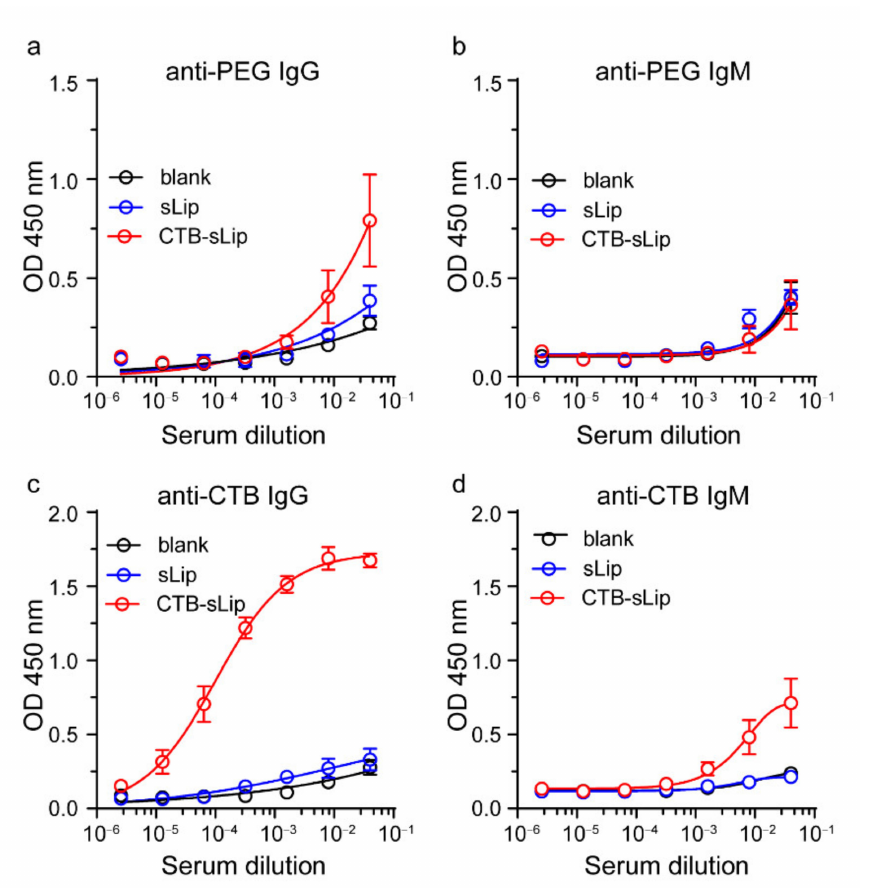
Figure 9. Immunogenicity of CTB-sLip in vivo. BALB/c mice were sequentially injected with sLip or CTB-sLip (50 mg kg − 1 lipids) per week for 21 days. Anti-PEG IgG/M ( a , b ) and anti-CTB IgG/M ( c , d ) in serum on day 21 were detected by ELISA. Data are means ± SDs ( n = 3).